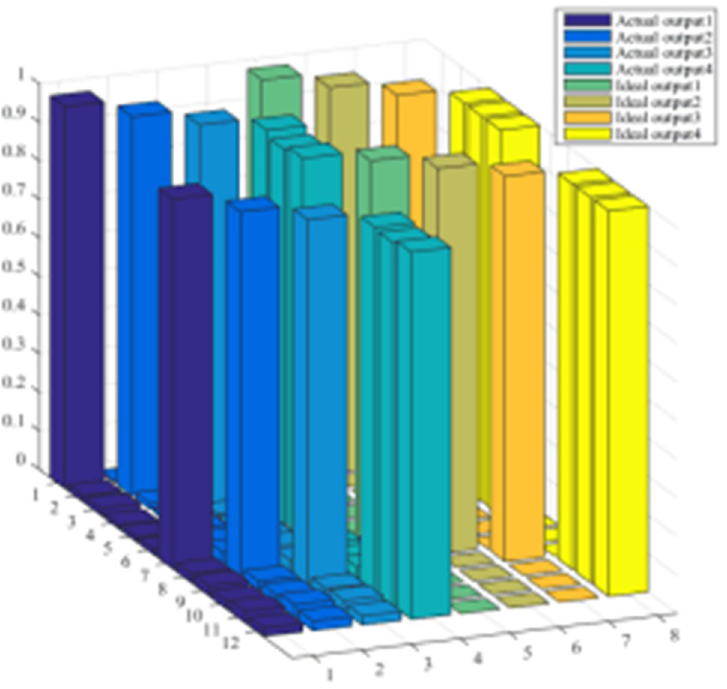
Fig 5. Analysis of ANN2 test